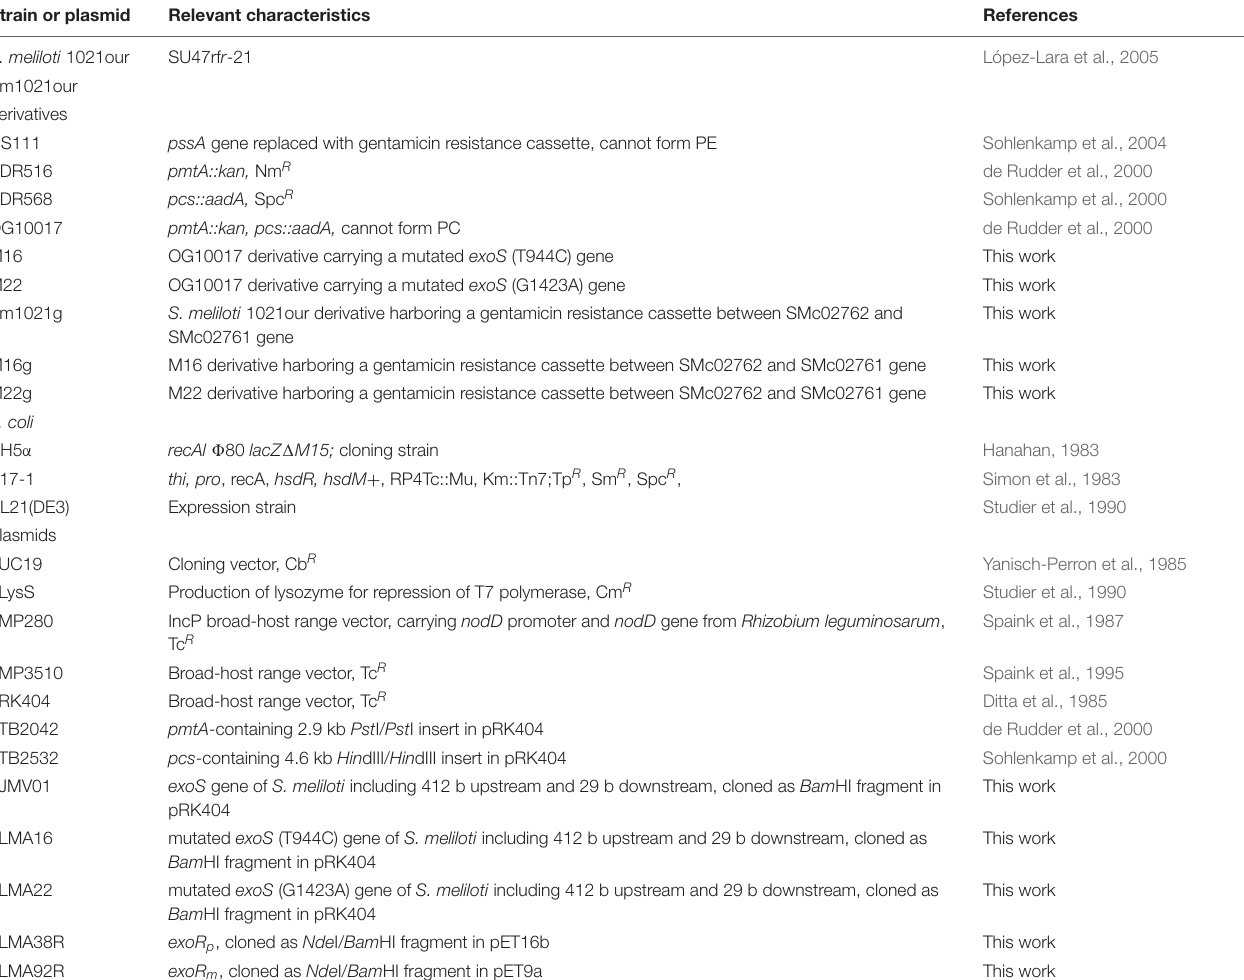
TABLE 4 | Bacterial strains and plasmids used in this